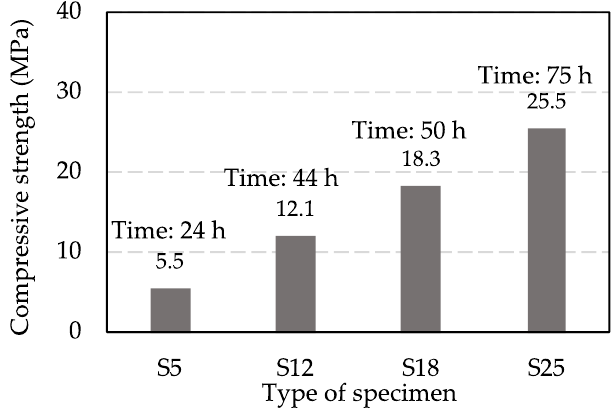
Figure 2. Determination of actual compressive strength and curing time.